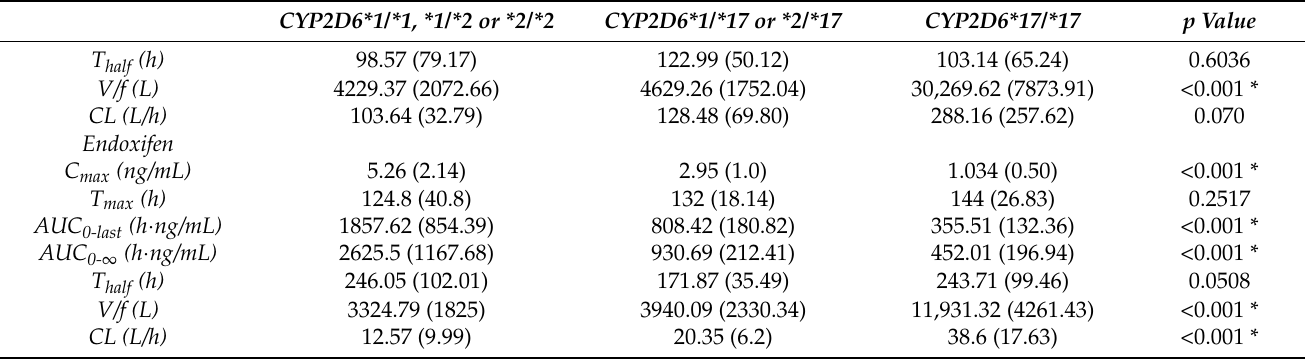
Data represented as mean (standard deviation). Analysis of variance (ANOVA) was used to test for the differences between the means of the key pharmacokinetic (PK) parameters: area under the plasma concentration–time curve (AUC), peak plasma concentration of the compound (Cmax), time needed to achieve Cmax (T max ), T half , elimination half-life, hours (hr), clearance (CL), the apparent volume of distribution (V/f), AUC0-last, area under